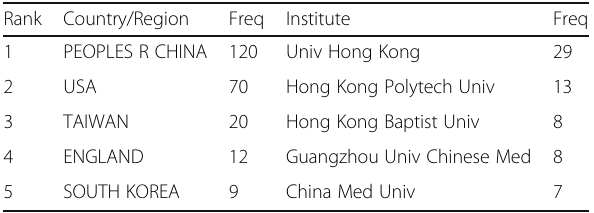
Table 3 Top 5 country/region and institute related toacupuncture for